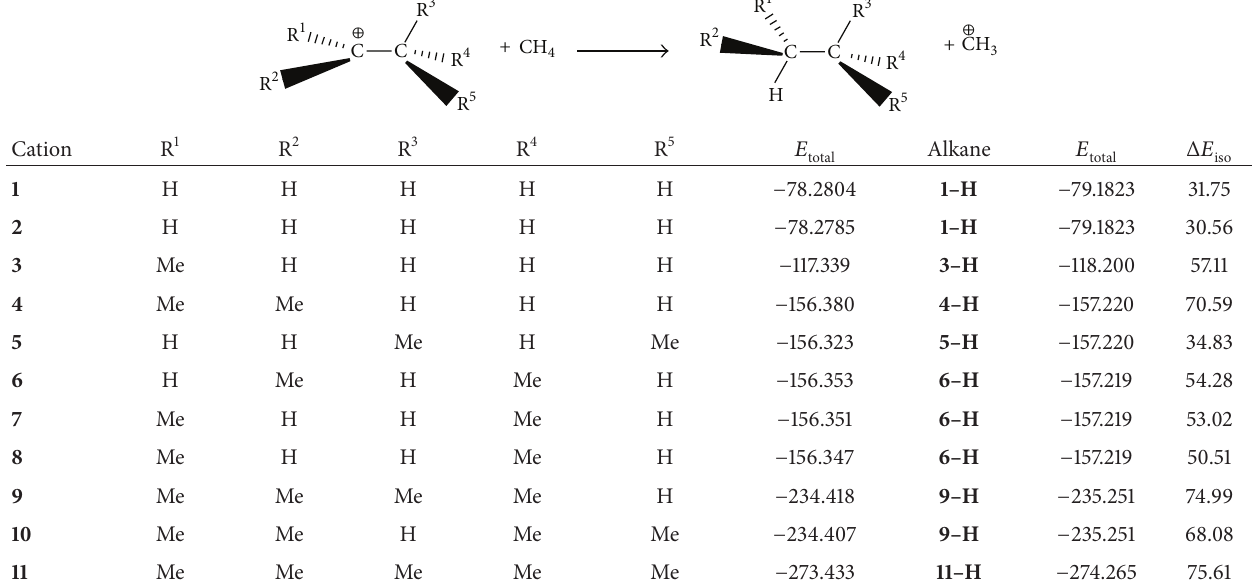
Table 5: Total energies 𝐸 (Hartree) of alkyl-substituted ethyl cations 1 – 11 and reaction energies (kcal/mol) of corresponding isodesmic total reactions a